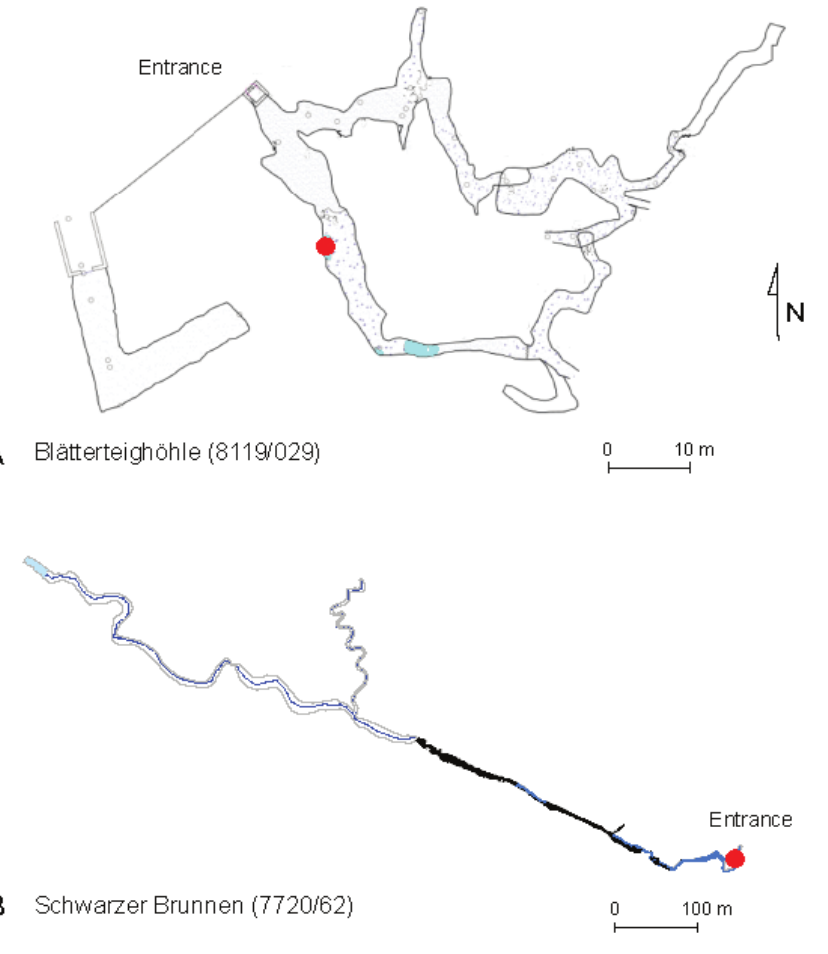
Figure 1. Plan of the two sampled caves. Sampling sites are marked with a red dot. Map kindly provided by Freunde der Aachhöhle (Blätterteighöhle) and Raphael Grimm (Schwarzer Brunnen),